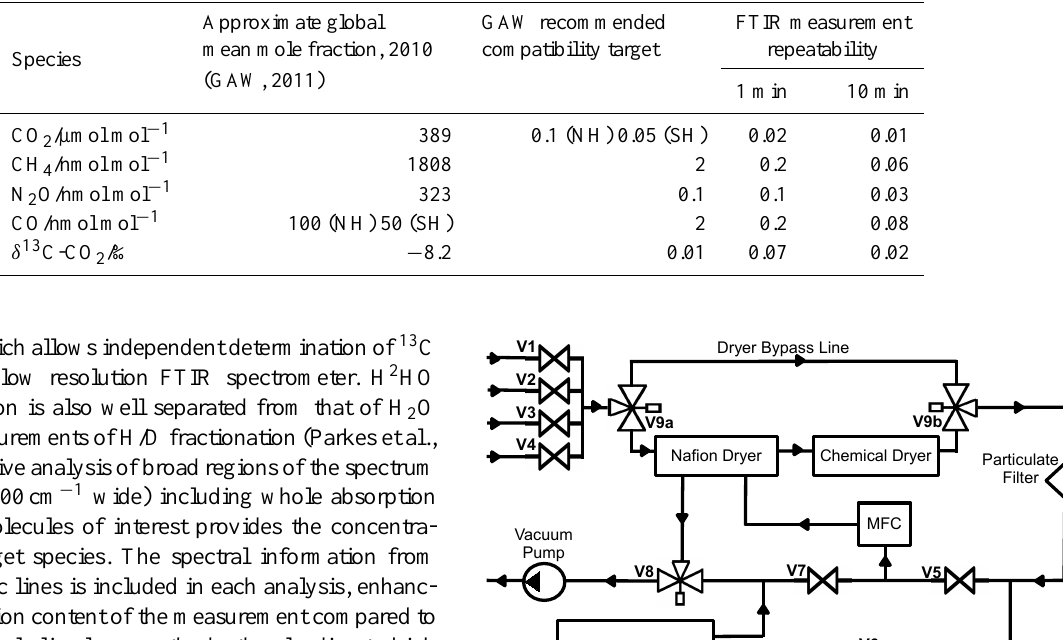
Table 1. Global mean mole fractions, GAW measurement compatibility requirements, and FTIR analyser measurement precision (Allan deviation for 1- and 10-min averaging times) for target trace gases.